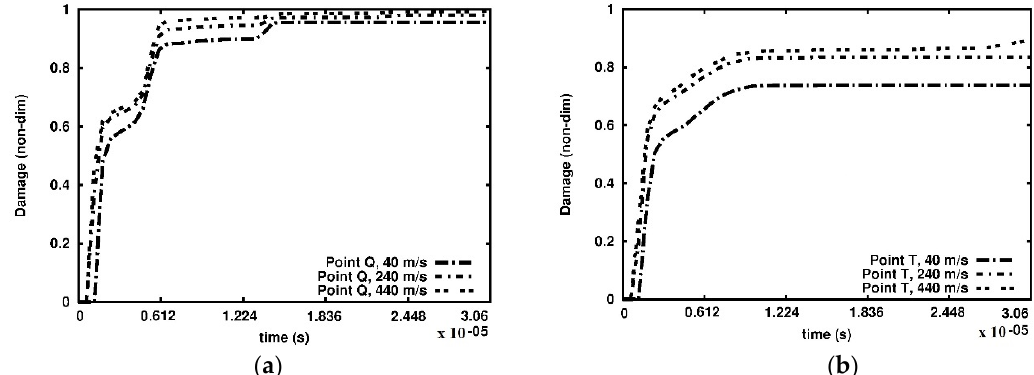
Figure 11. Damage parameter variation, cross-section B-B: ( a ) point Q; ( b ) point T.